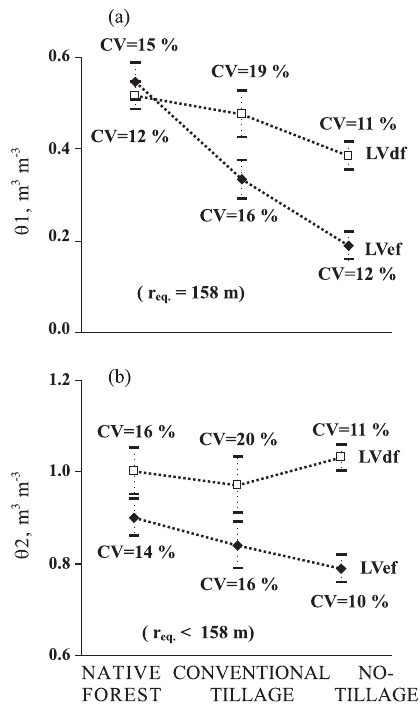
Figure 3. Average values (for 20 replications with 10 samples per profile at each sampling location) and confidence interval (95 %) for intra- aggregate porosity (a) and (b) at a pressure of 10 kPa, determined in 10 cm 3 clods collected in the LVdf and LVef (dystroferric and eutroferric Red Oxisols) in the 5–50 cm layer, representing the crop